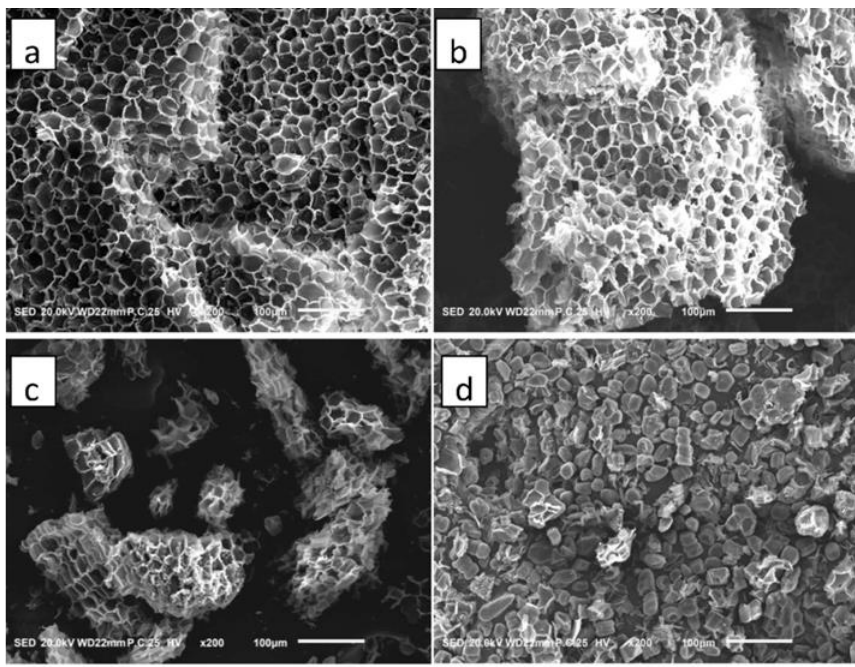
Figure 3. FE-SEM images of cork particles with different sizes: ( a ) <20 mesh, ( b ) 40 – 100 mesh, ( c ) 100 – 200 mesh, ( d ) 200 – 300 mesh.